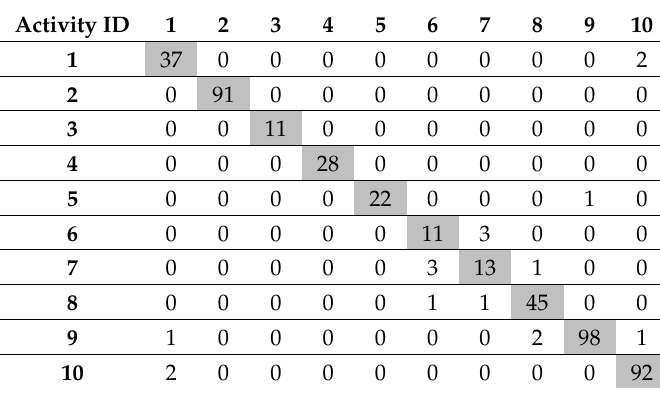
Table 4. Confusion matrix of recognized